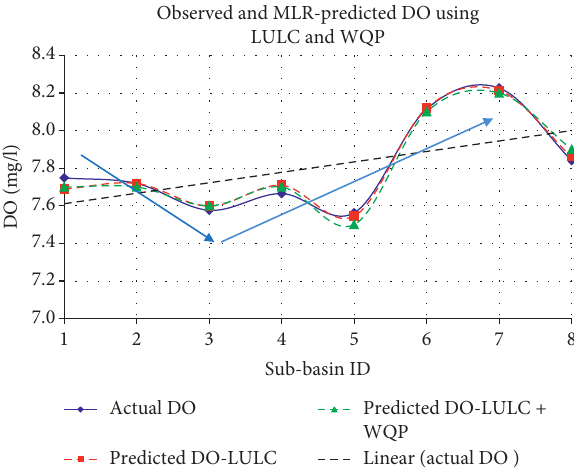
Figure 7: Observed and MLR-predicted DO concentrations using LULC in each